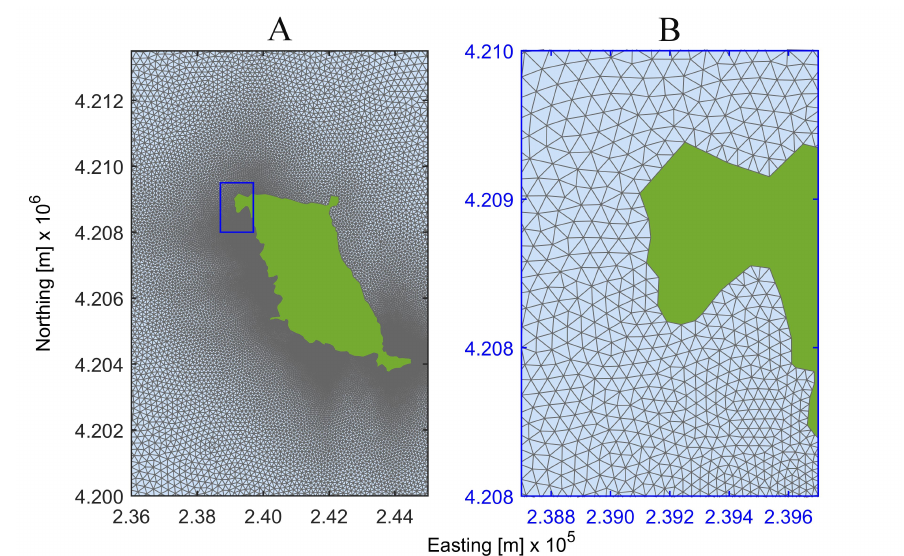
Figure 4. ( A ) computational grid domain around the Marettimo Island. The right panel ( B ) shows the triangular unstructured mesh detail.